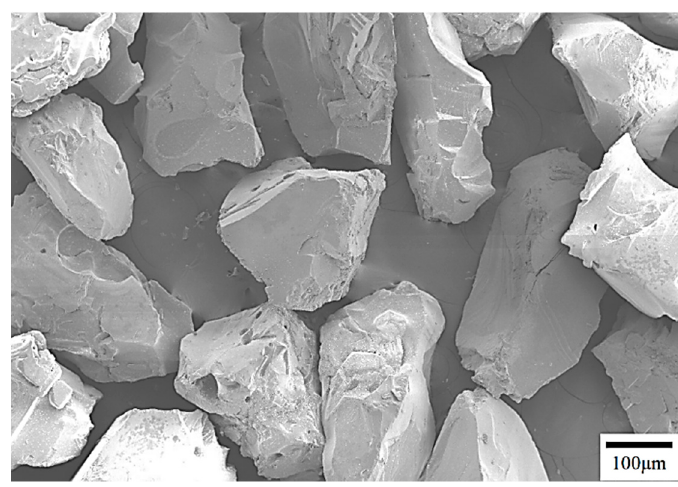
Figure 3. Scanning electron microscope ( SEM) morphology of Al 2 O 3 erosion particles.